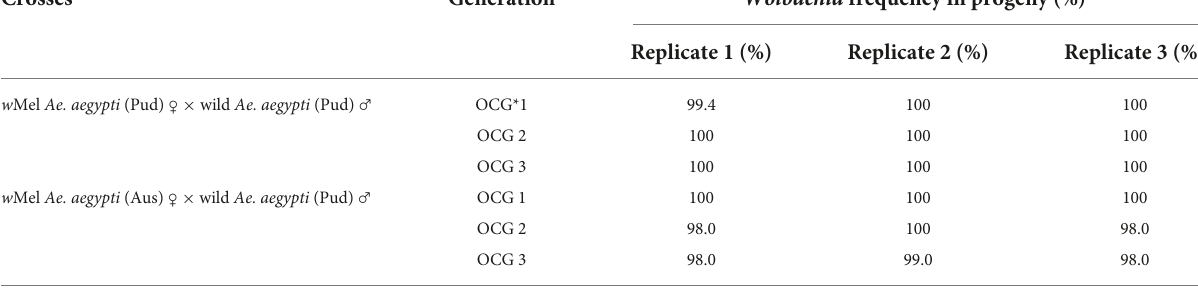
TABLE 1 Maternal transmission of Wolbachia assessed from the progeny of crosses between w Mel-infected Ae. aegypti females and uninfected wild Ae. aegypti males. Crosses